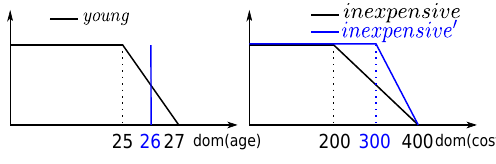
Fig. 5. t.m.f of young , inexpensive and inexpensive